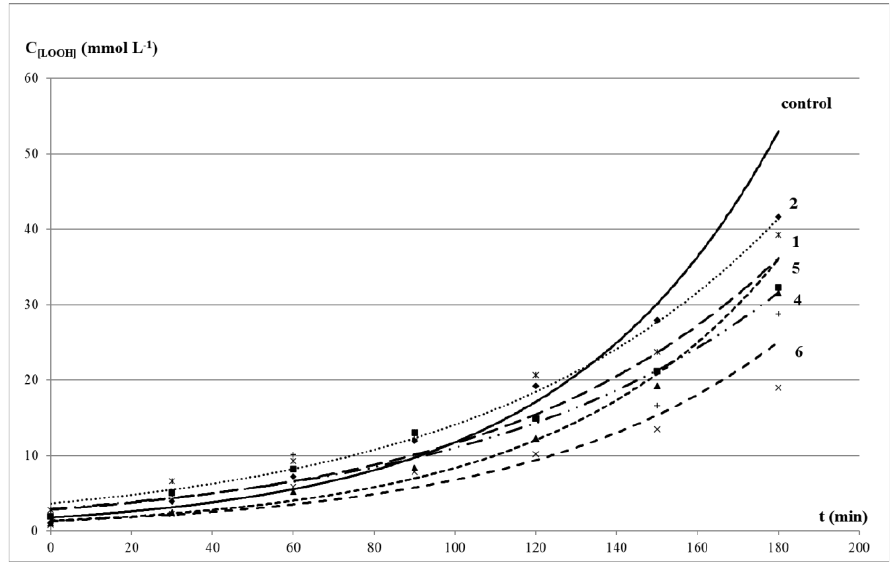
Figure 2. Kinetic curves of LOOH formation in the presence of 1 mmol/L additives at 65 °C: ( control ) oleic acid without additives; ( 1 ) diphenyl trisulfide; ( 2 ) bis(2-methoxyphenyl) disulfide; ( 4 ) 4,4′ -dihydroxydiphenyl disulphide; ( 5 ) diphenyl disulfide; ( 6 ) bis(3,5-di- tert -butyl-4-hydroxyphenyl) disulphide.